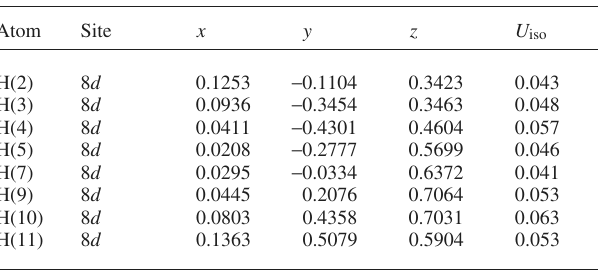
Table 2. Atomic coordinates and displacement parameters (in Å 2 )